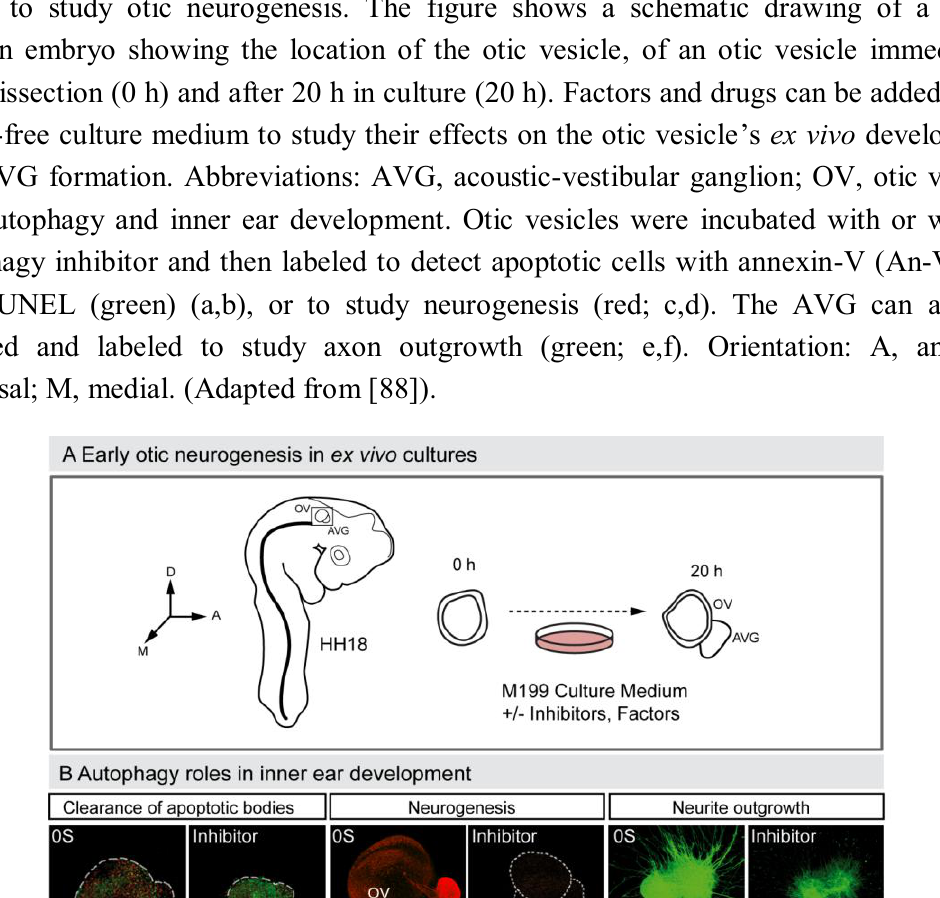
Figure 3. Autophagy in early otic neurogenesis. ( A ) Schematic representation of the